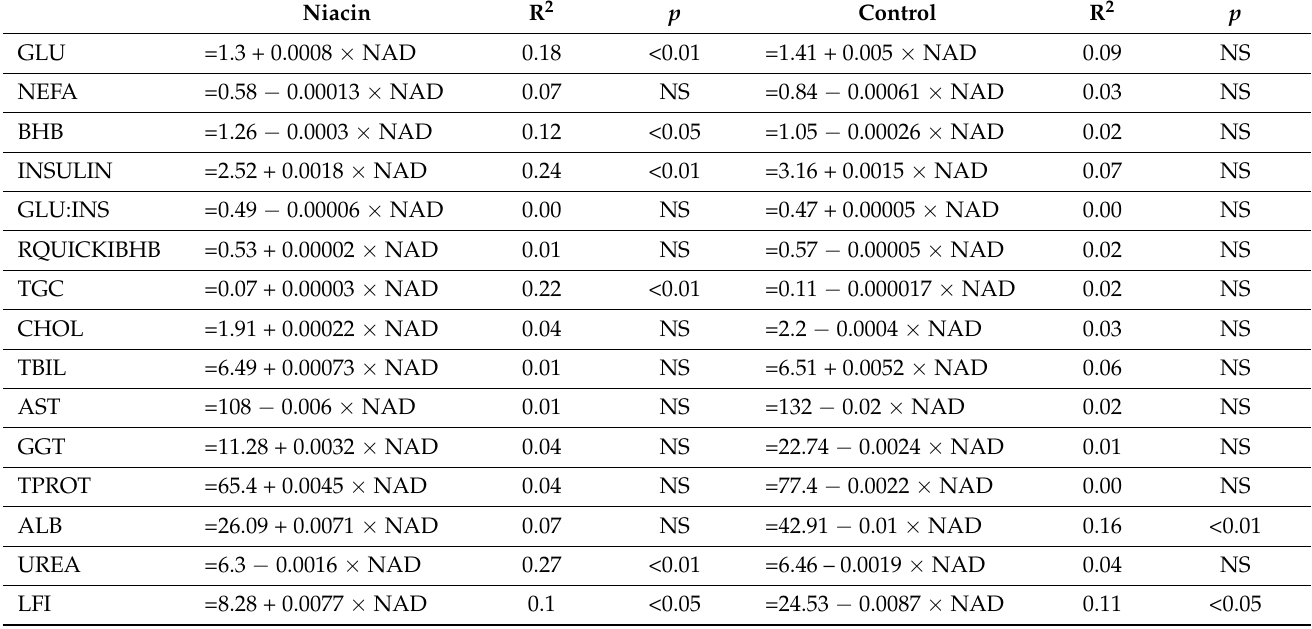
Table 2. Relationship of metabolic parameters with NAD values in cows that received and did not receive additional niacin. Abbreviations: Nicotinamide adenine dinucleotide (NAD), glu- cose (GLU), nonesterified fatty acid (NEFA), beta-hydroxybutyrate (BHB), glucose to insulin ra- tio (GLU:INS), Revised Quantitative Insulin Sensitivity Check Index with BHB (RQUICKIBHB), triglycerides (TGC), cholesterol (CHOL), total bilirubin (TBIL), aspartate aminotransferase (AST), gamma-glutamiltransferase (GGT), total protein (TPROT), albumin (ALB) and liver functionality